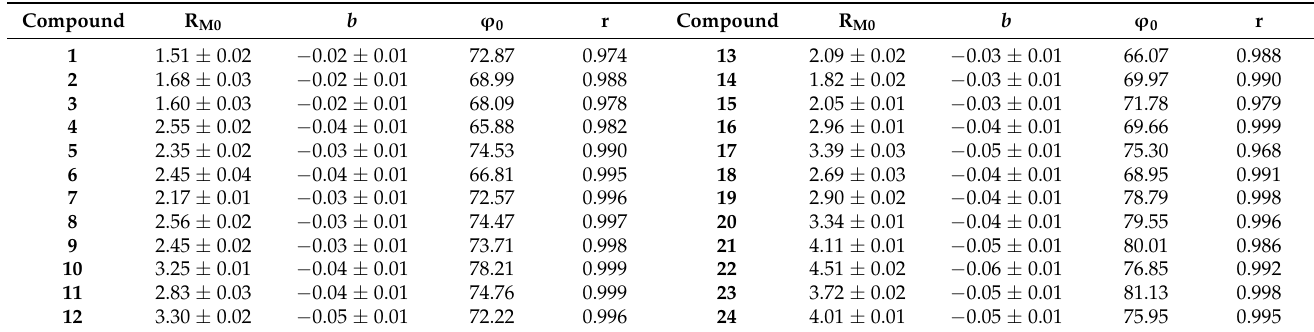
Table 1. The experimental values of R M0 , b , ϕ 0 and r for compounds 1 – 24 .